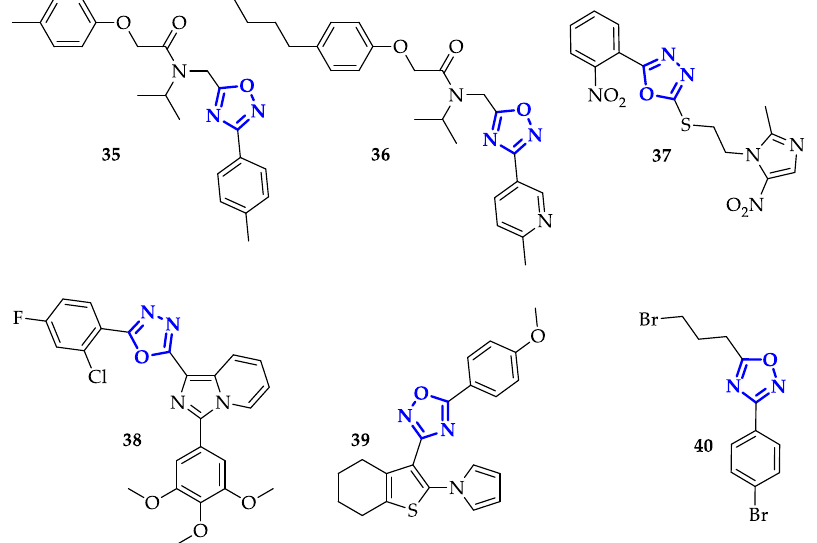
ff olds involved in di ff erent enzyme